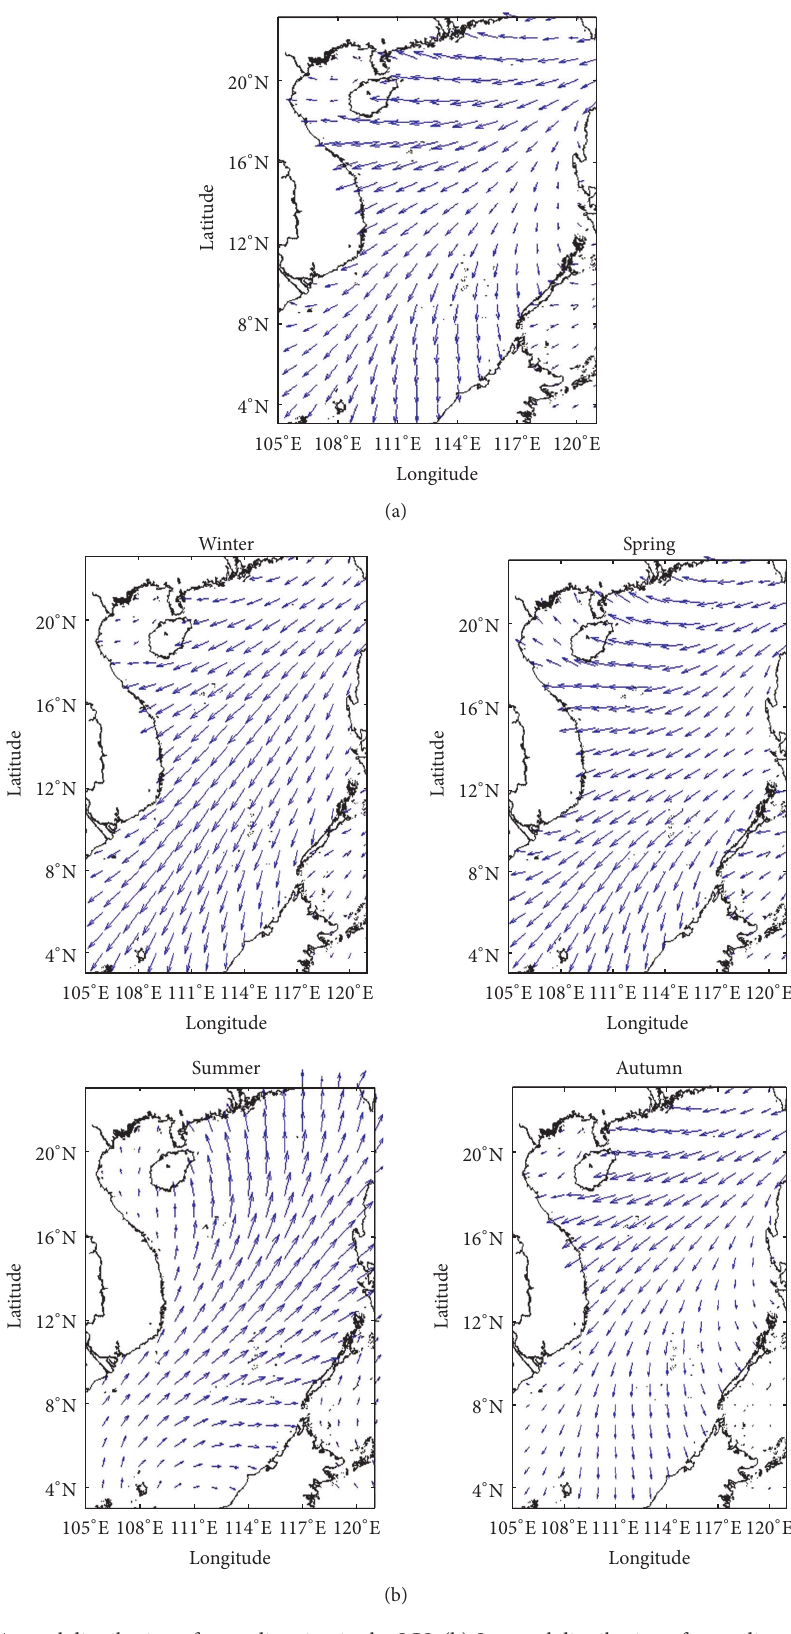
Figure 3: (a) Annual distribution of wave direction in the SCS. (b) Seasonal distribution of wave direction in the